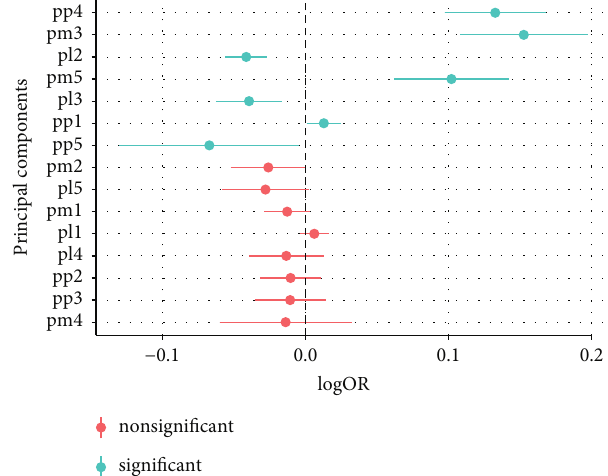
Figure 2: Logistic regression models, with significance testing, of the main PCs when comparing MHO (a) with MUO (b) subjects.